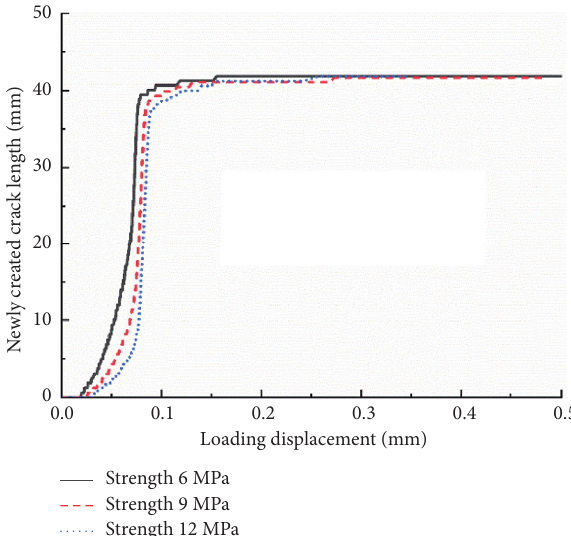
Figure 16: Effect of fracture energy on the crack length development.